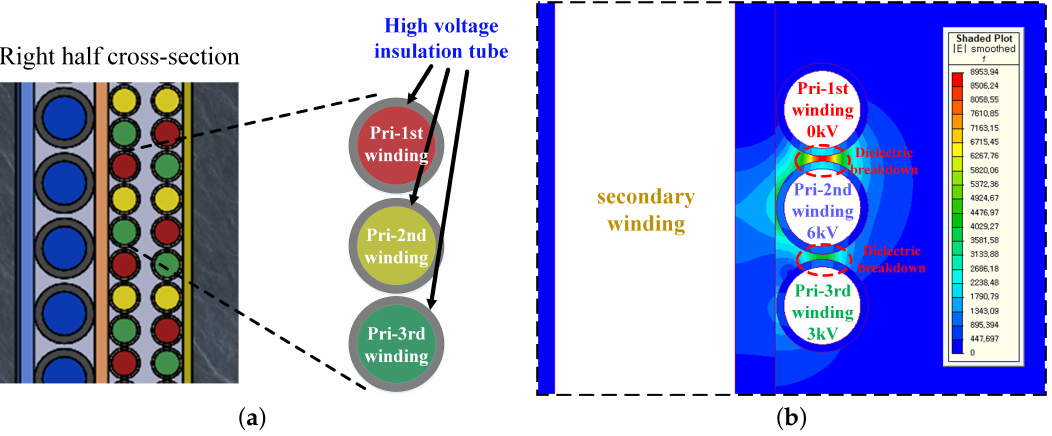
Figure 3. Electric potential difference: ( a ) winding structure; ( b ) electric field simulation results.